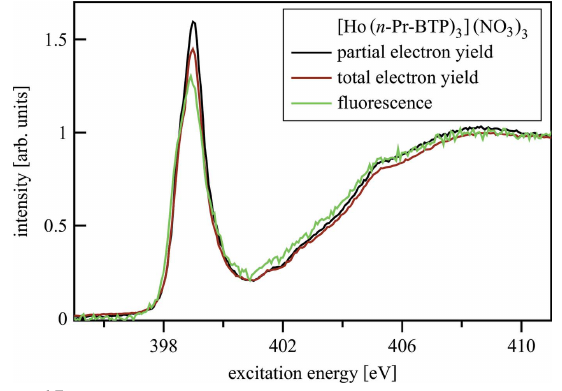
Figure 15 N K -edge spectra of [Ho( n -Pr-BTP) 3 ](NO 3 ) 3 measured in different detection modes.